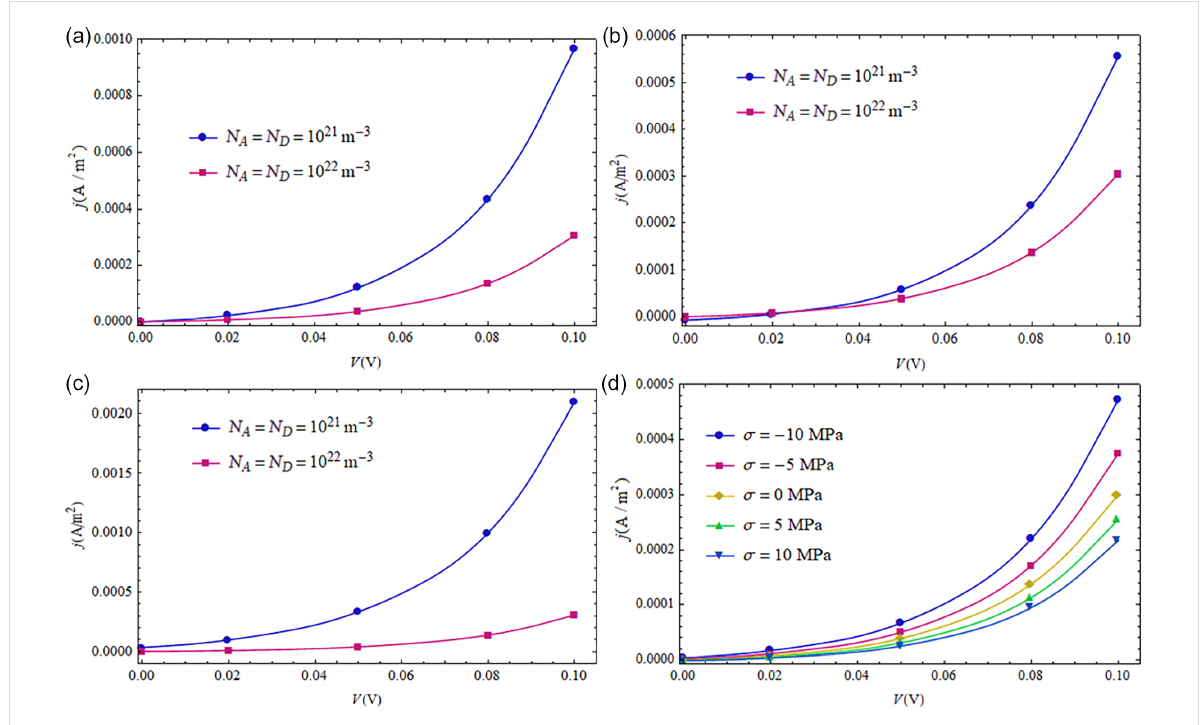
Figure 9: I – V characteristics of a CdS p–n junction with different doping concentrations exposed to mechanical stress: (a) σ = 0 MPa. (b) σ = 5 MPa. (c) σ = − 5 MPa. (d) Effect of mechanical loadings on a CdS p–n junction with N A = N D = 1 × 10 22 m − 3